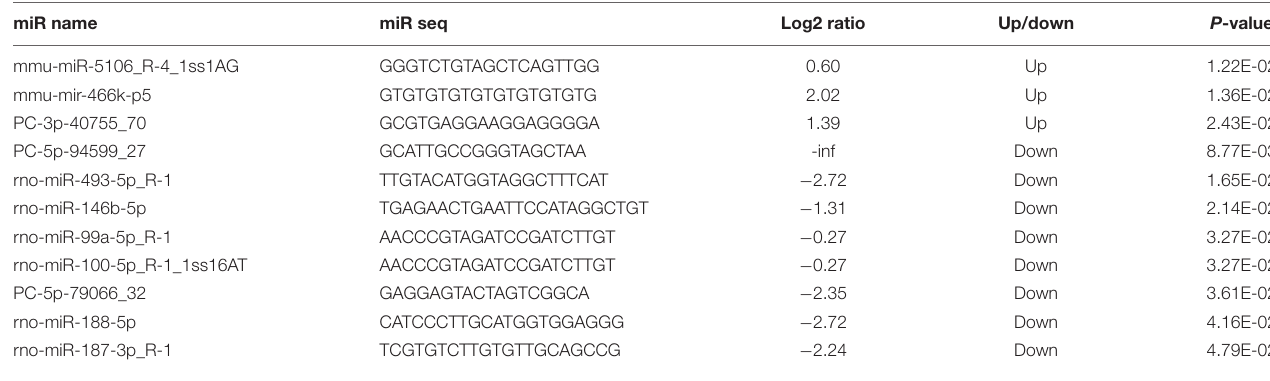
TABLE 2 | Differentially expressed